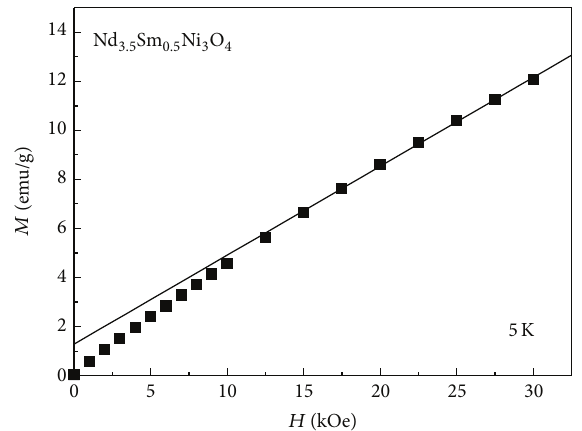
Figure 7: Field dependence of magnetization for sulfur-deinterca- lated Nd 3.5 Sm 0.5 Ni 3 O 8